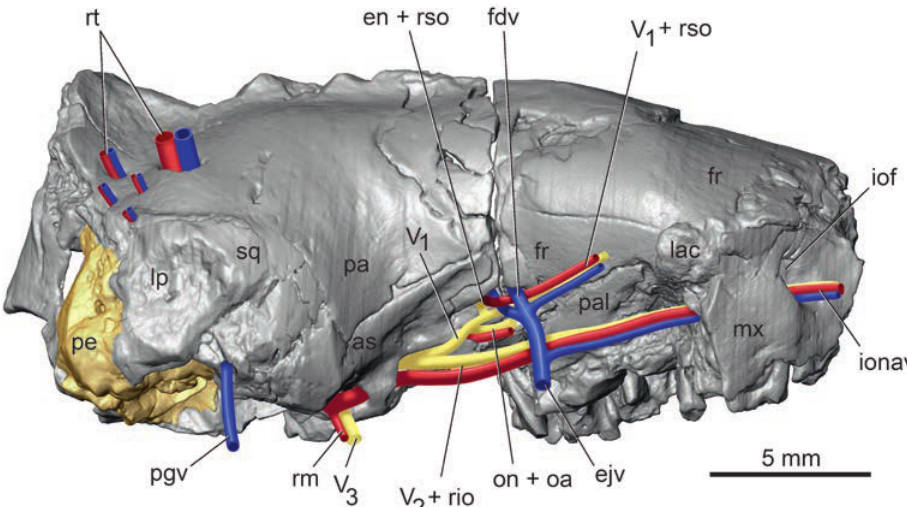
Fig. 6. Palaeoryctid mammal Eoryctes melanus Thewissen and Gingerich, 1989, UM 68074 (UM locality SC-133, Clarks Fork Basin, Wyoming, USA; early Wasatchian Land-Mammal Age, early Eocene), isosurface of cranium rendered from CT scans in right lateral view, with neurovascular structures reconstructed based in part on Avizo segmentation (right petrosal in gold; arteries in red; veins in blue; nerves in yellow). As noted in text, the spheno- palatine foramen is not preserved due to damage and, therefore, the expected sphenopalatine artery was omitted from the reconstruction. Abbreviations: as, alisphenoid; ejv, external jugular vein; en + rso, ethmoidal nerve and ramus supraorbitalis with accompanying vein; fdv, frontal diploic vein; fr, frontal; iof, infraorbital foramen; ionav, infraorbital nerve, artery, and vein; lac, lacrimal; lp, lambdoid plate; mx, maxilla; pa, parietal; pal, palatine; pe, petrosal; pgv, postglenoid vein; rm, ramus mandibularis; rt, ramus temporalis with accompanying vein; sq, squamosal; V 1 + rso, ophthalmic nerve and ramus su- praorbitalis with accompanying vein; V 2 + rio, maxillary nerve and ramus infraorbitalis; V 3 , mandibular